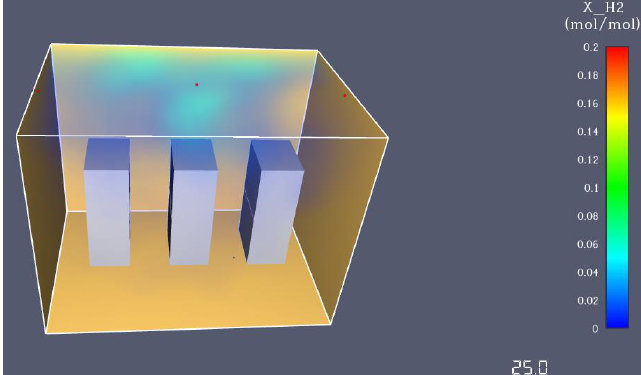
Figure 14. Full pipe rupture with 120ACH and 2 s delay.